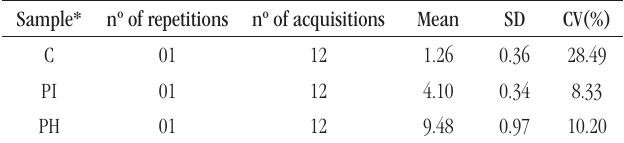
tABLE 3 – Accuracy of flow cytometry for reticulocyte counting using AO (new protocol))